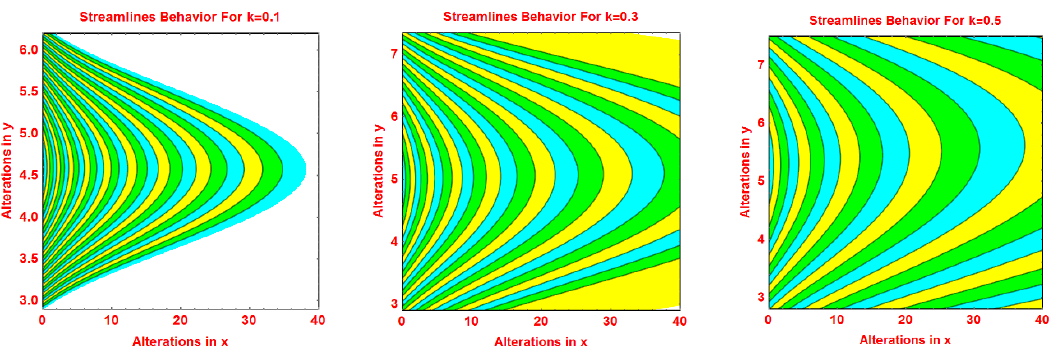
Figure 7. E ff ects of di ff erent values of k on the streamlines pattern. Figure 7. Effects of different values of k on the streamlines pattern. Figure 7. Effects of different values of k on the streamlines pattern. Figure 7. Effects of different values of k on the streamlines pattern.